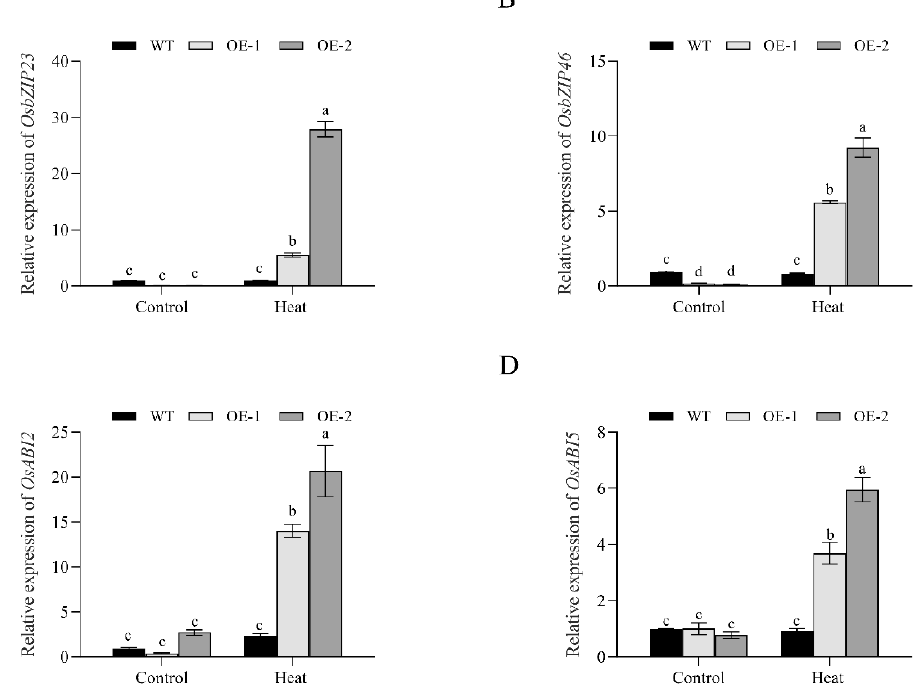
Figure 8. Transcription of ABA signaling-related genes, including OsbZIP23 ( A ), OsbZIP46 ( B ), OsABI2 ( C ) and OsABI5 ( D ), were analyzed by qRT-PCR under HS in WT and transgenic lines . WT and overexpression lines were exposed to HS (45 °C) for 5 days, and leaf samples were collected for RNA extraction, cDNA synthesis, and qRT-PCR analysis. Data shown are means ± SD of three independent experiments. Statistical analysis was performed by ANOVA test ( p < 0.05), and significant differences are indicated by different letters.